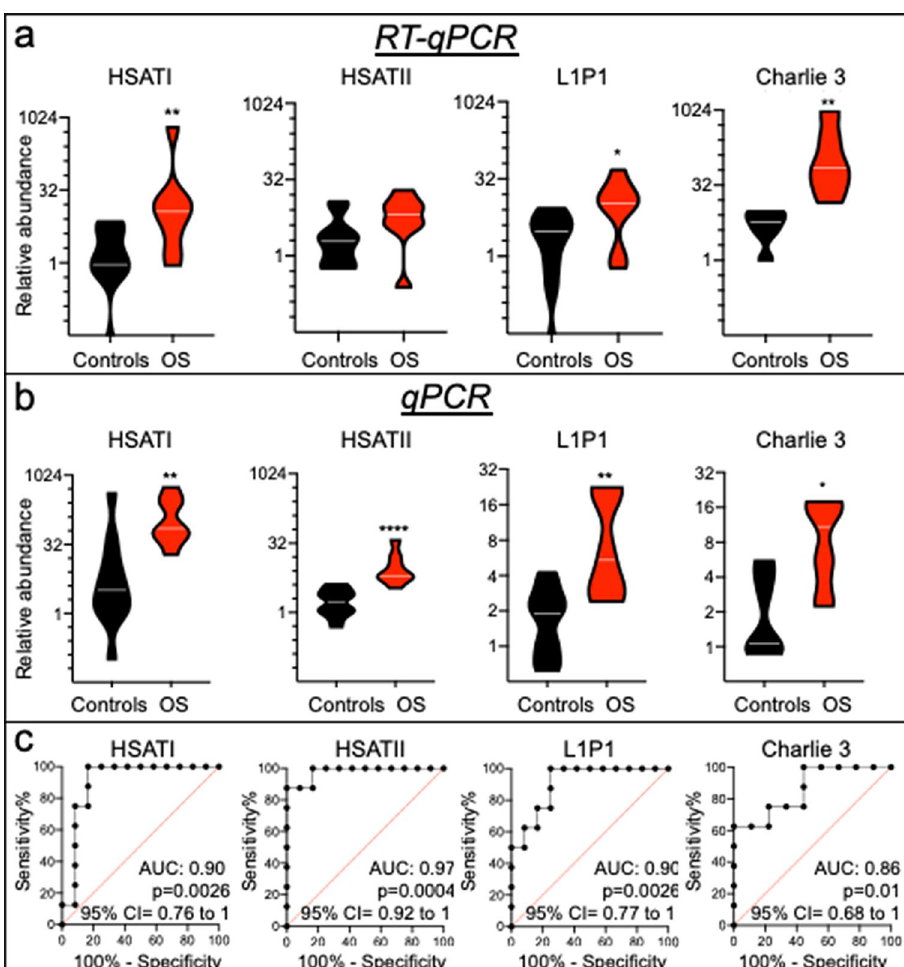
Figure 3. Over-representation of repetitive elements in OS compared to control EV preparations in a validation cohort. ( a ) Violin plots representing relative abundance of HSATI , HSATII , L1P1 and Charlie 3 by RT-qPCR of control (n = 6–11) and OS (n = 7–8) serum EV preparations. RT-qPCR was normalized against C. elegans external spike-in miR-39–3p RNA. White lines represent median. ( b ) Violin plots representing relative abundance of HSATI , HSATII , L1P1 and Charlie 3 DNA by qPCR, in the absence of reverse transcription, in control (n = 12) and OS (n = 8) serum EV preparations. qPCR was performed on equal proportions of nucleic acid extracted from 200 ul of OS and control serum. White lines represent median. ( c ) Diagnostic value of HSATI , HSATII , L1P1 and Charlie 3 DNA sequences in serum OS preparations. ROC curves were generated using data in ( b ). Groups were compared using two ‐ tailed, unpaired, Mann Whitney U test; * p < 0.05; ** p < 0.01; *** p <